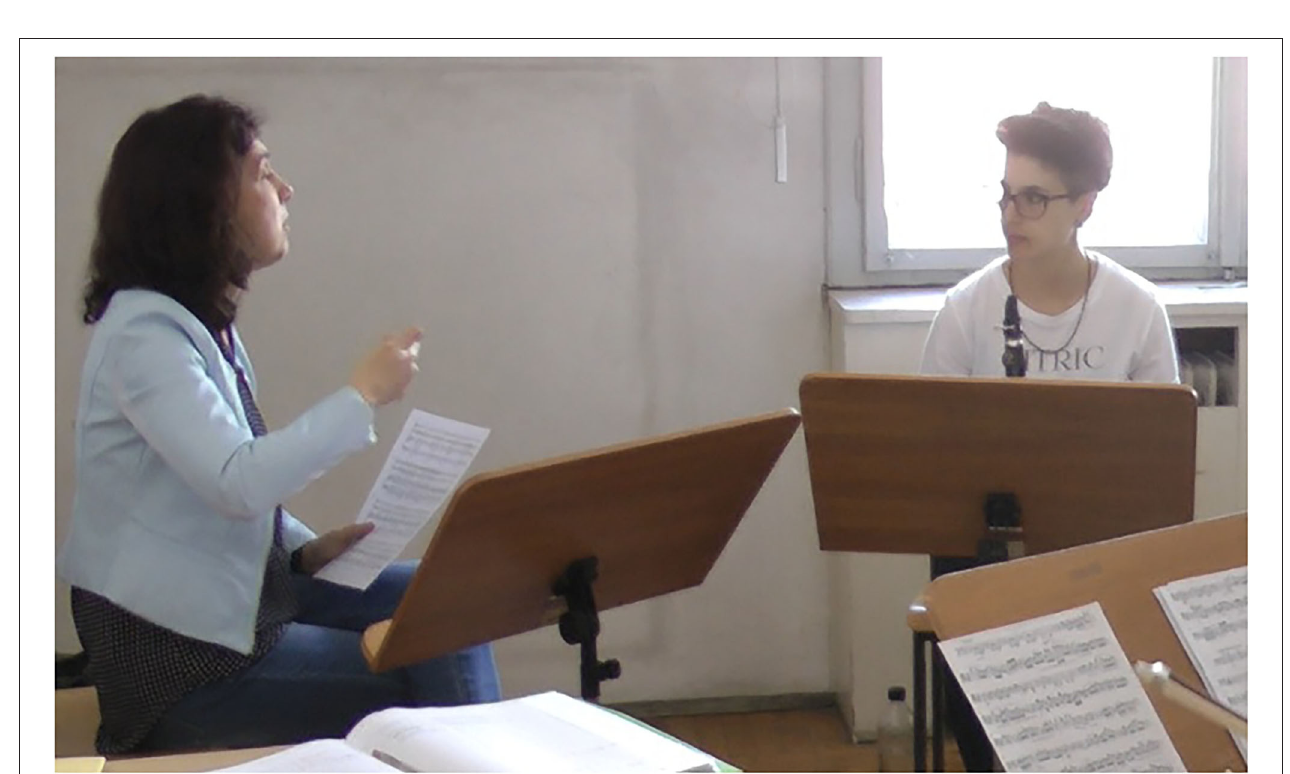
FIGURE 4 | Professor moves right hand forwards in a semicircle.